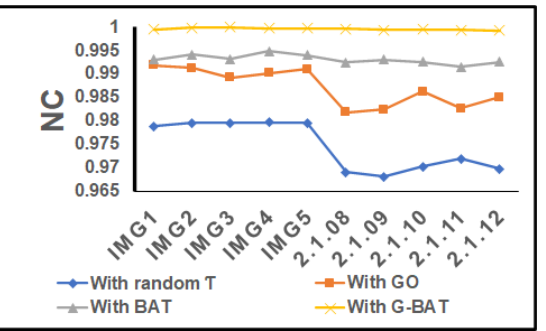
Figure 9. NC for the 10 test aerial cover images with random Γ , with GO, with BAT and with G-BAT under zero attacks.